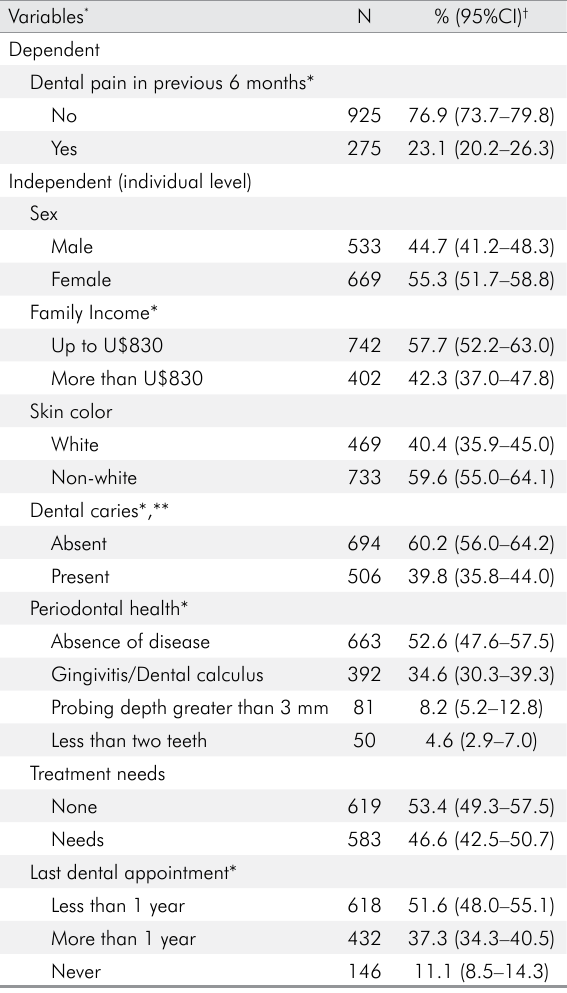
Table 2. Descriptive analysis of individual variables for the sample of adolescents (n = 1,200), Minas Gerais Oral Health Study, Brazil, 2012.